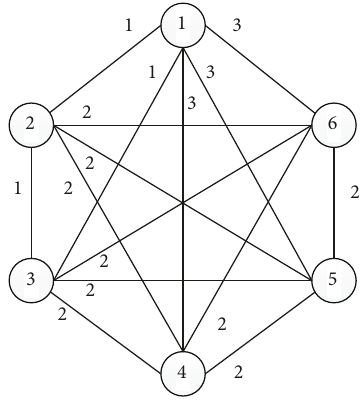
Figure 5: A graph with nontrivial